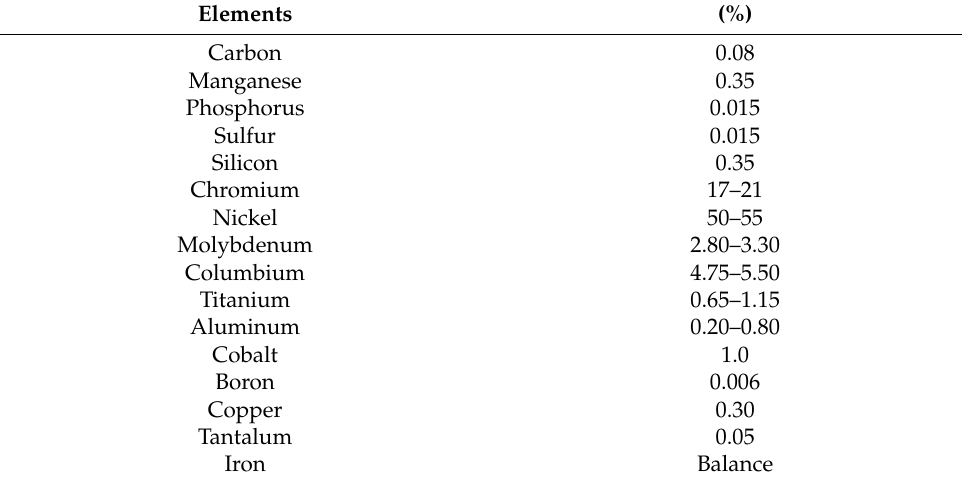
Table 2. Chemical composition of Inconel 718 powder particles